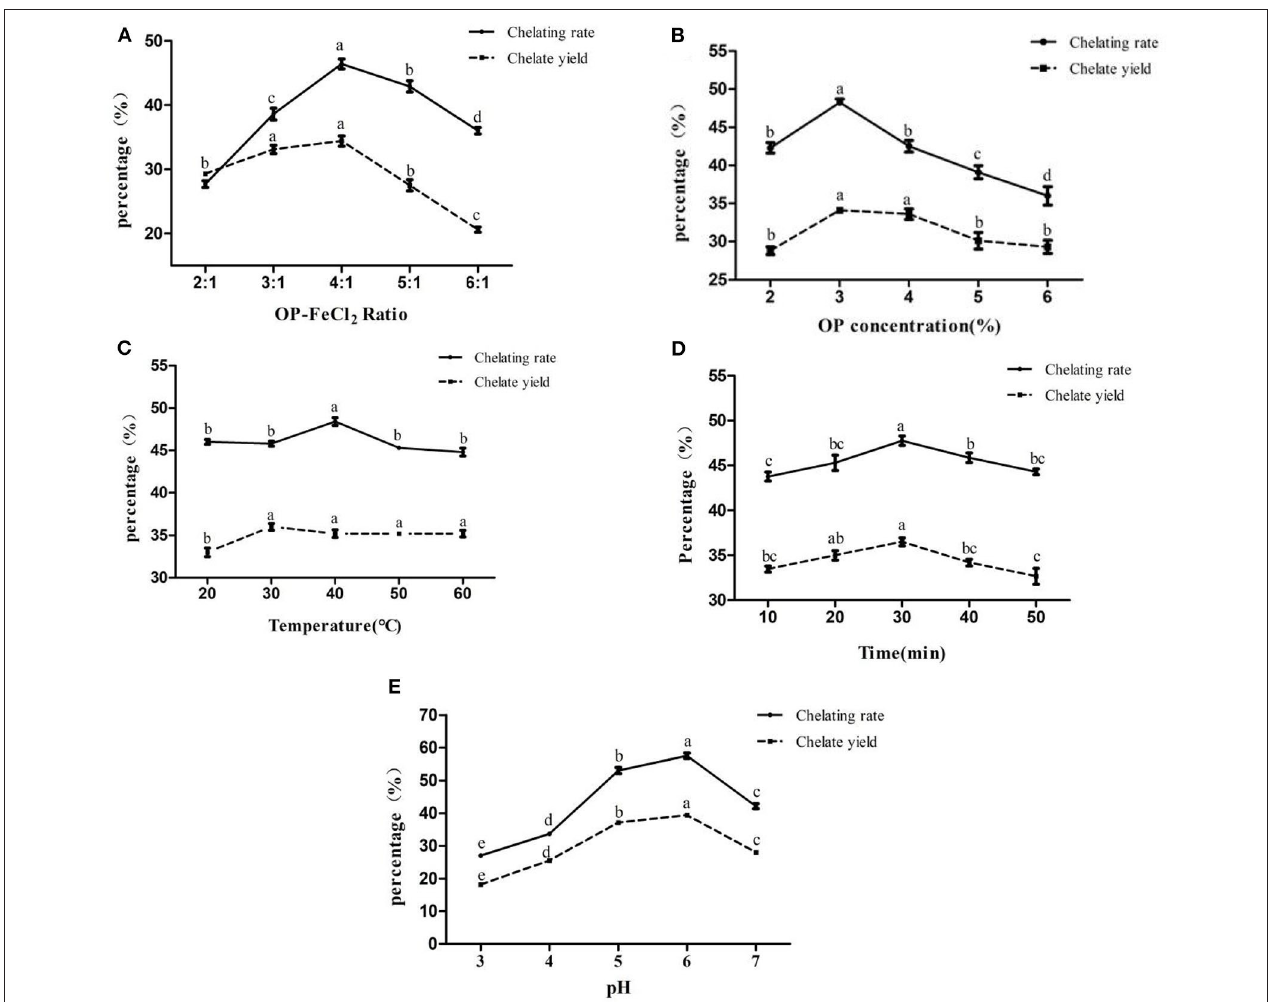
FIGURE 1 | Effects of different binding conditions on chelating rate and chelate yield ( A :OP-FeCl2 ratio, B :OP concentration, C : Temperature, D : Time, E :pH). In the same index, different letters indicate that there are significant differences between different levels ( p < 0.05), whereas, the same letters mean that there are no statistical differences between different levels ( p > 0.05).